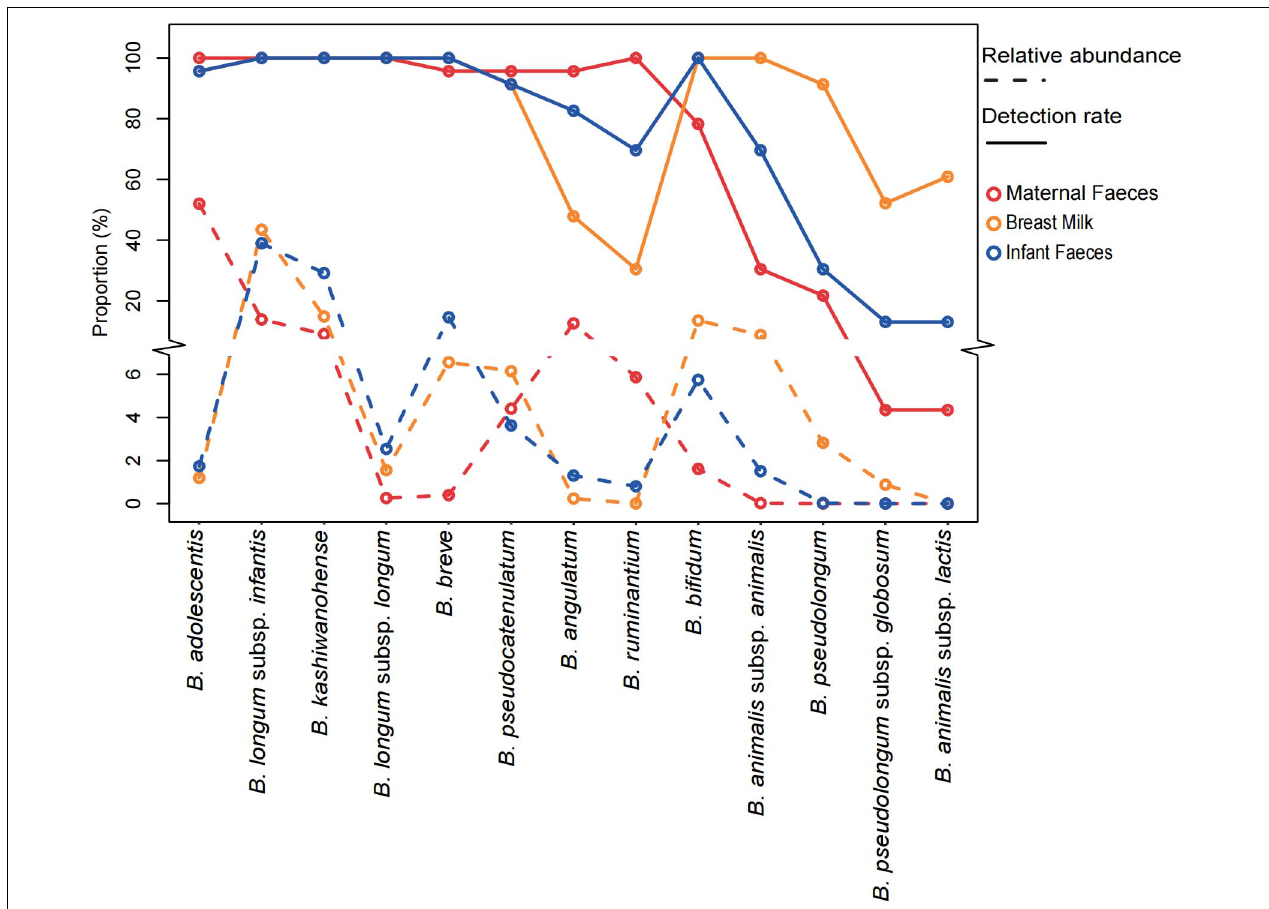
FIGURE 5 | The relative abundance and detection rate of 13 Bifidobacterium species or subspecies in the three systems of 23 mother–infant pairs. The y-axis truncation value is